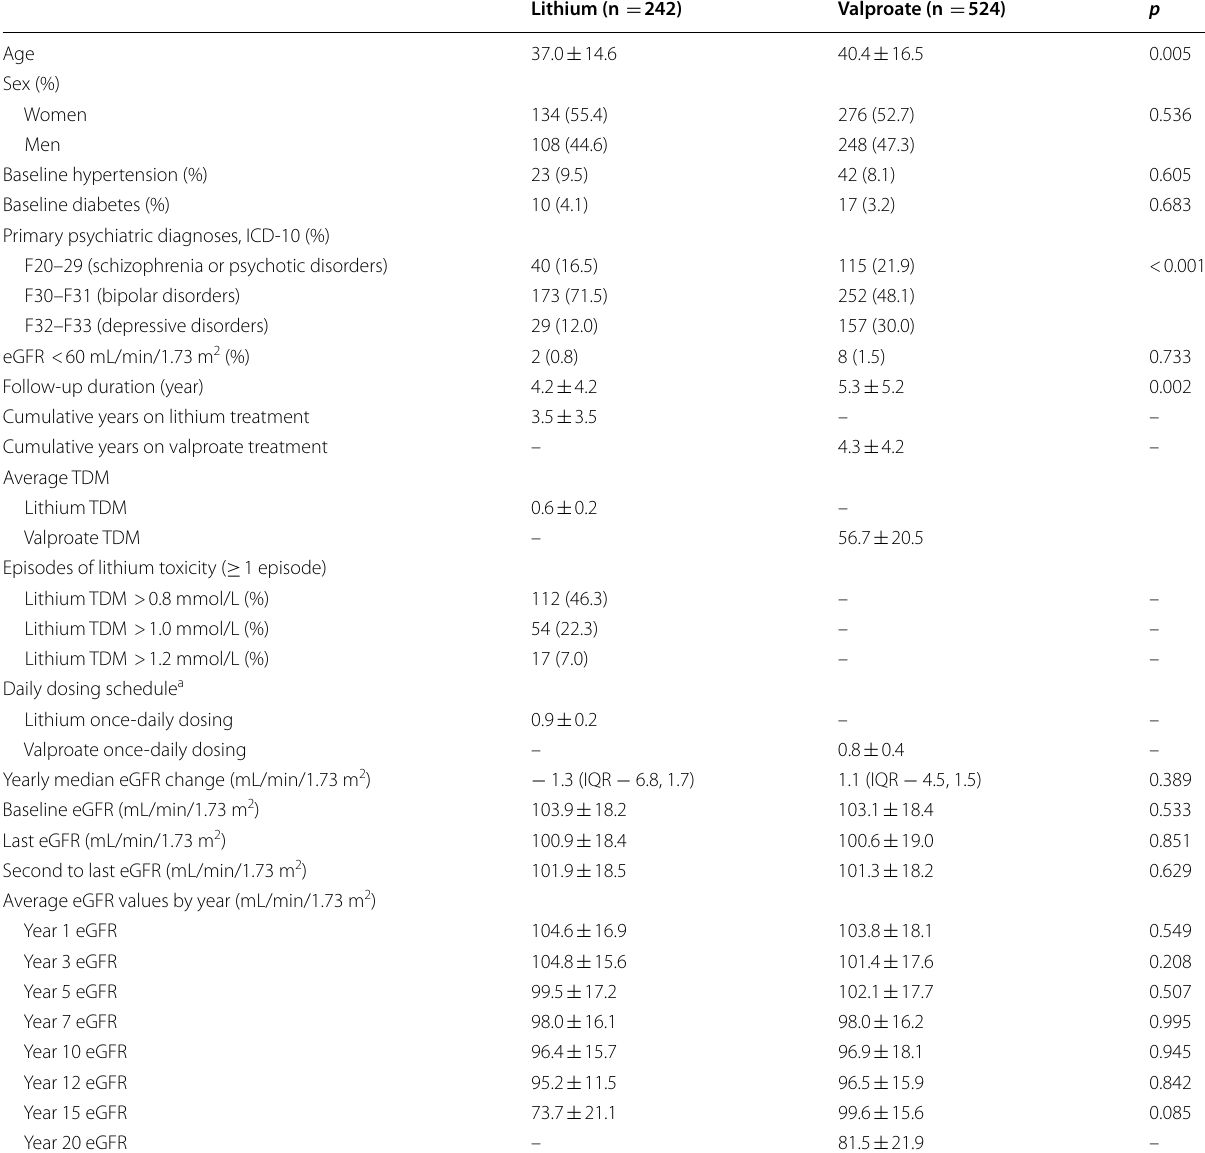
Table 1 Baseline characteristics of